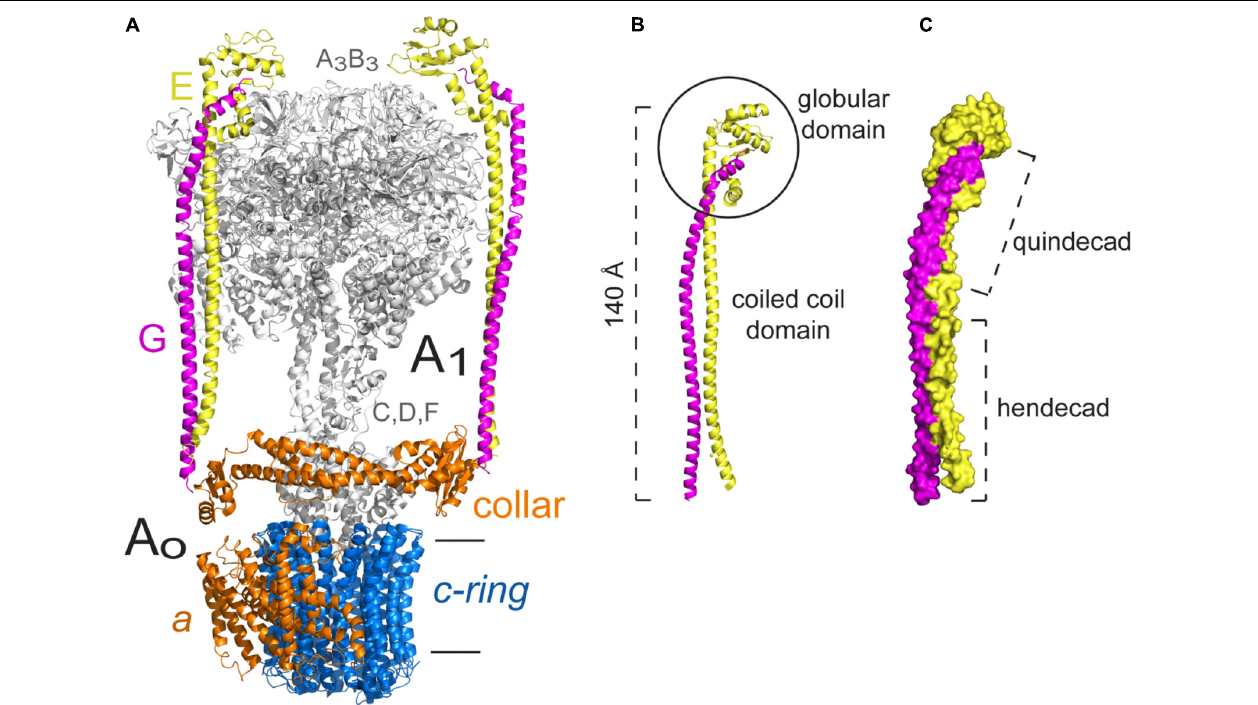
FIGURE 5 | Peripheral stalk of the Thermus thermophilus A-ATPase. (A) Three dimensional model of the archaeal enzyme (Schep et al., 2016) PDB 5GAR, in which the peripheral stalks, the collar-like structure made by subunit a and the c -ring are colored. (B) Model of the EG heterodimer in which the coiled coil domain and the globular domain are indicated. (C) Model of the EG heterodimer that illustrates the right handed coiling of the helices and the two types of coiling that result from the hendecad motifs in both subunits, and quindecad repeat motifs in subunit G. The model used in B,C corresponds to the structural data deposited with the PDB 3V6I (Stewart et al., 2012). The black horizontal lines indicate the mitochondrial inner